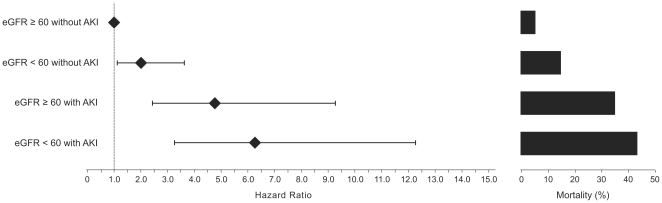
Hospital admission eGFR, AKI development and 30-day mortality rates after acute myocardial infarction.Hazard ratio (Cox multivariate analysis, left) and crude mortality (right).